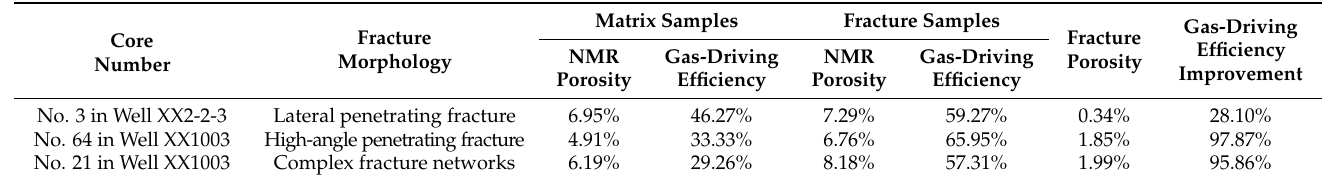
Figure 9. Fracture morphology after fracture: ( a ) No. 3 of Well XX2-2-3; ( b ) No. 64 of Well XX1003; ( c ) No. 21 of Well XX1003. Table 4. Relationship between fracture morphology and gas-driving efficiency before and after fracture in three wells.